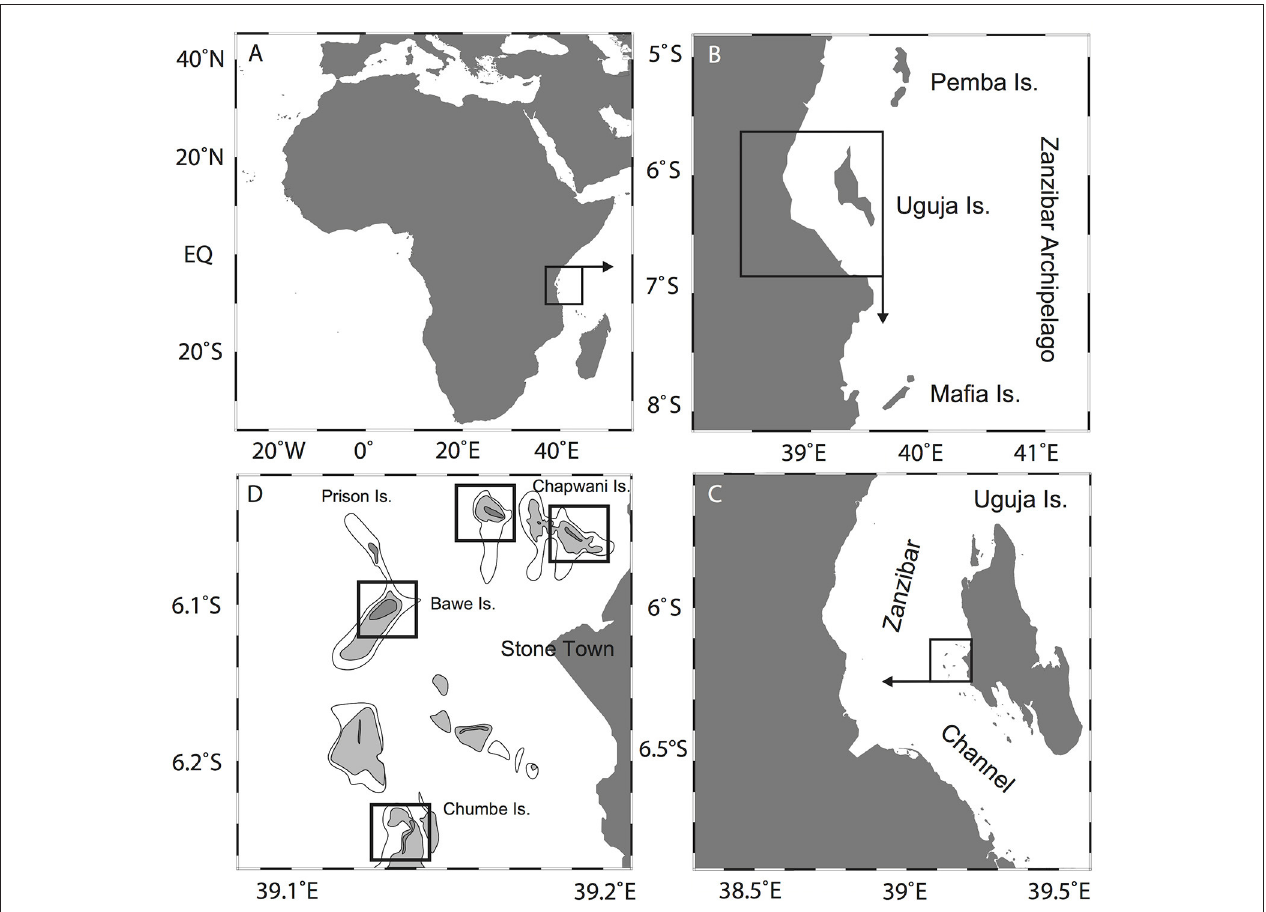
FIGURE 1 | Location of the study area showing (A) the African continent; (B) Zanzibar (Unguja) Island; (C) Zanzibar Archipelago, off of Stone Town; and (D) Zanzibar island chain and location of our study